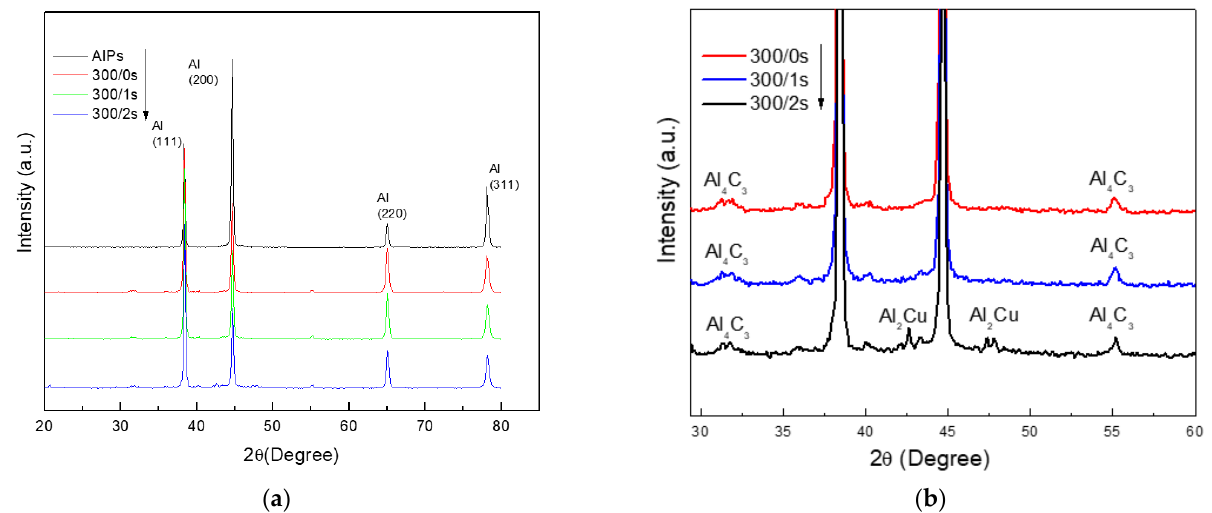
Figure 2. ( a ) X-ray diffraction spectrum for the sintered composites with 3 wt.% C content and the AlPs sample. ( b ) Image enlargement of X-ray diffraction profiles.